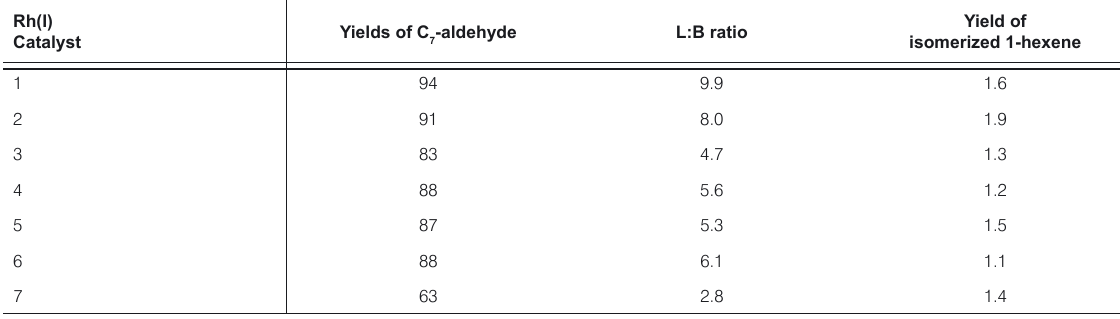
Yields of C -aldehyde L:B ratio 7